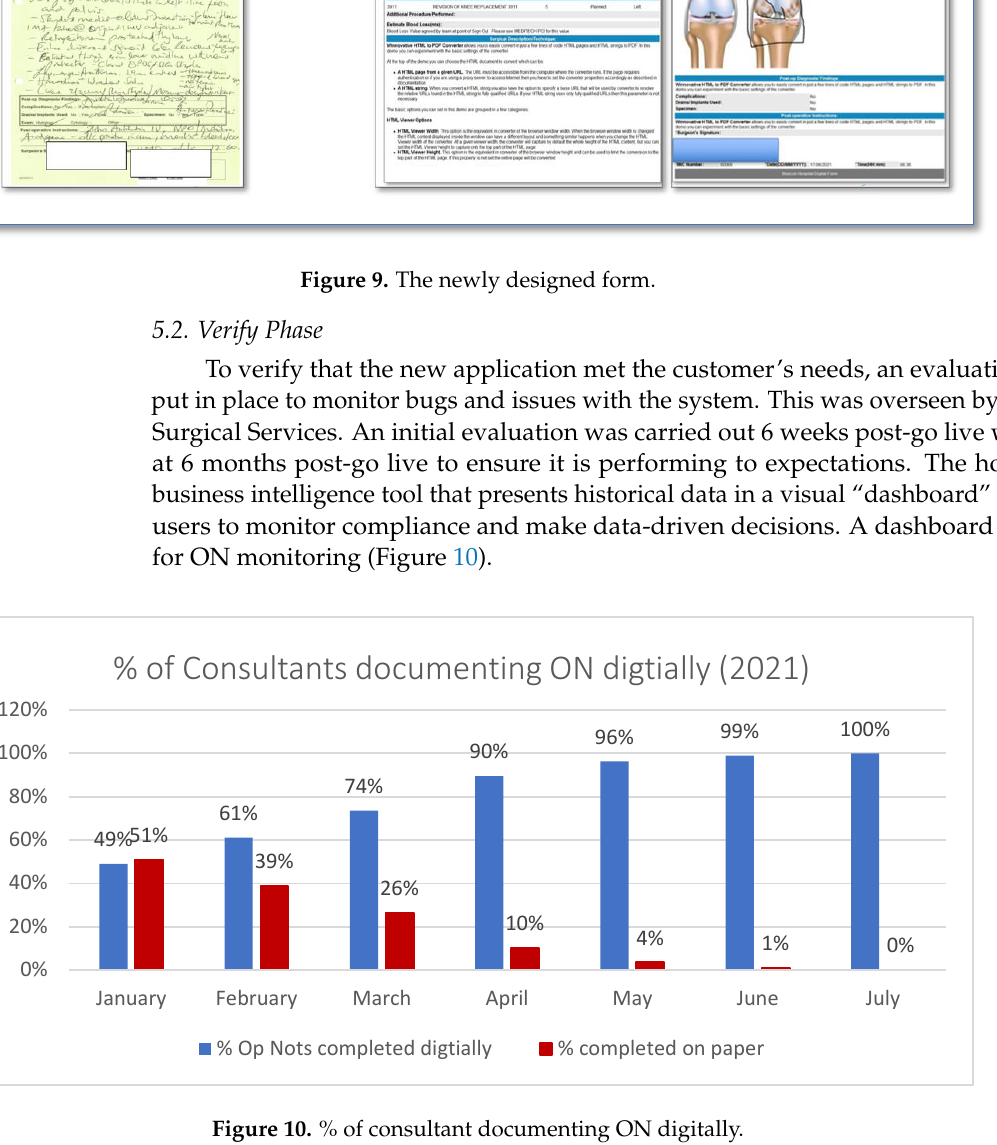
Figure 10. % of consultant documenting ON